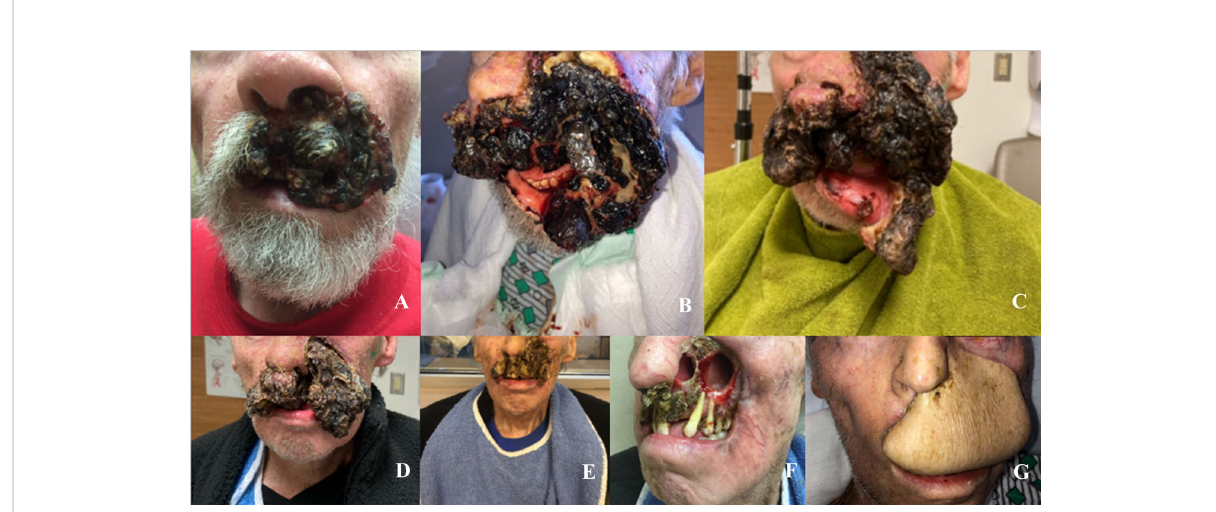
FIGURE 2 (A-G) Lesion During Treatment Progression: (A) August 2020, First presentation to dermatology; (B) November 6, 2020, prior to initiating cemiplimab; (C) December 4, 2020, after 1 cycle of cemiplimab; (D) December 22, 2020, after 2 cycles of cemiplimab and 1 cycle of QuadShot radiotherapy; (E) January 14, 2021, after 3 cycles of cemiplimab and 2 cycles of QuadShot radiotherapy; (F) February 11, 2021, after 4 cycles of cemiplimab and 2 cycles QuadShot radiotherapy; (G) October 2021, after debulking and reconstruction.